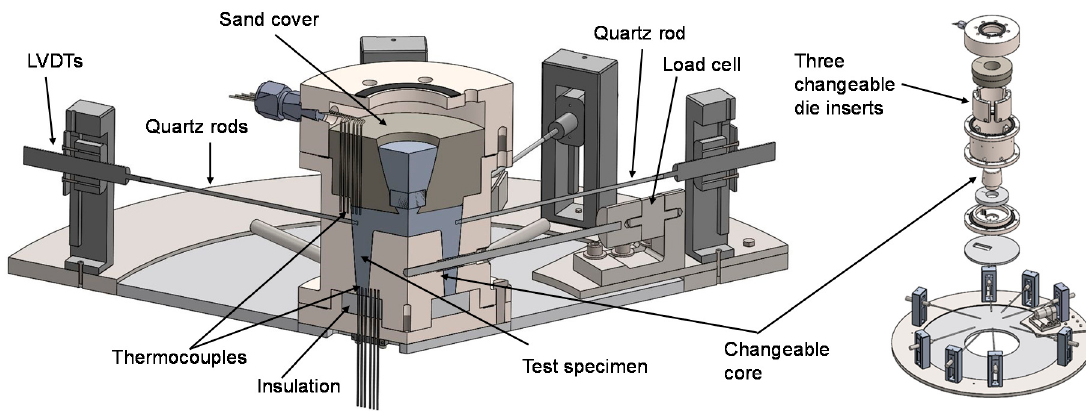
Figure 1. A section wise cutaway depiction of the experimental setup with a cast test specimen as well as the attached measuring devices on the left and an exploded view of the setup on the right [13].